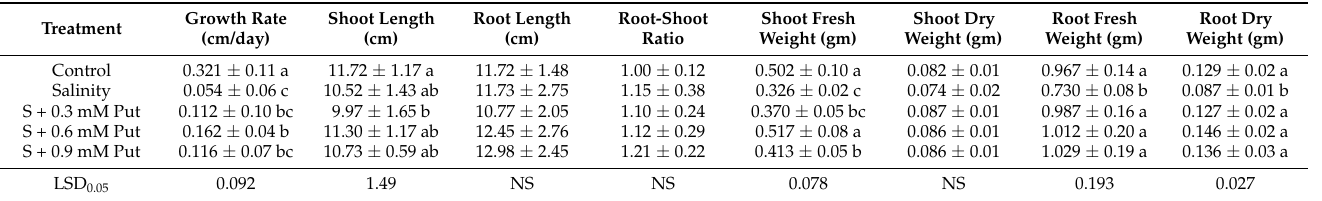
Table 1. Effect of foliar application of putrescine (Put) on the plant growth rate (GR), shoot length (SL), root length (RL), root-shoot ratio (RSR), shoot fresh weight (SFW), shoot dry weight (SDW), root fresh weight (RFW), and root dry weight (RDW) of ginseng sprouts grown under salinity